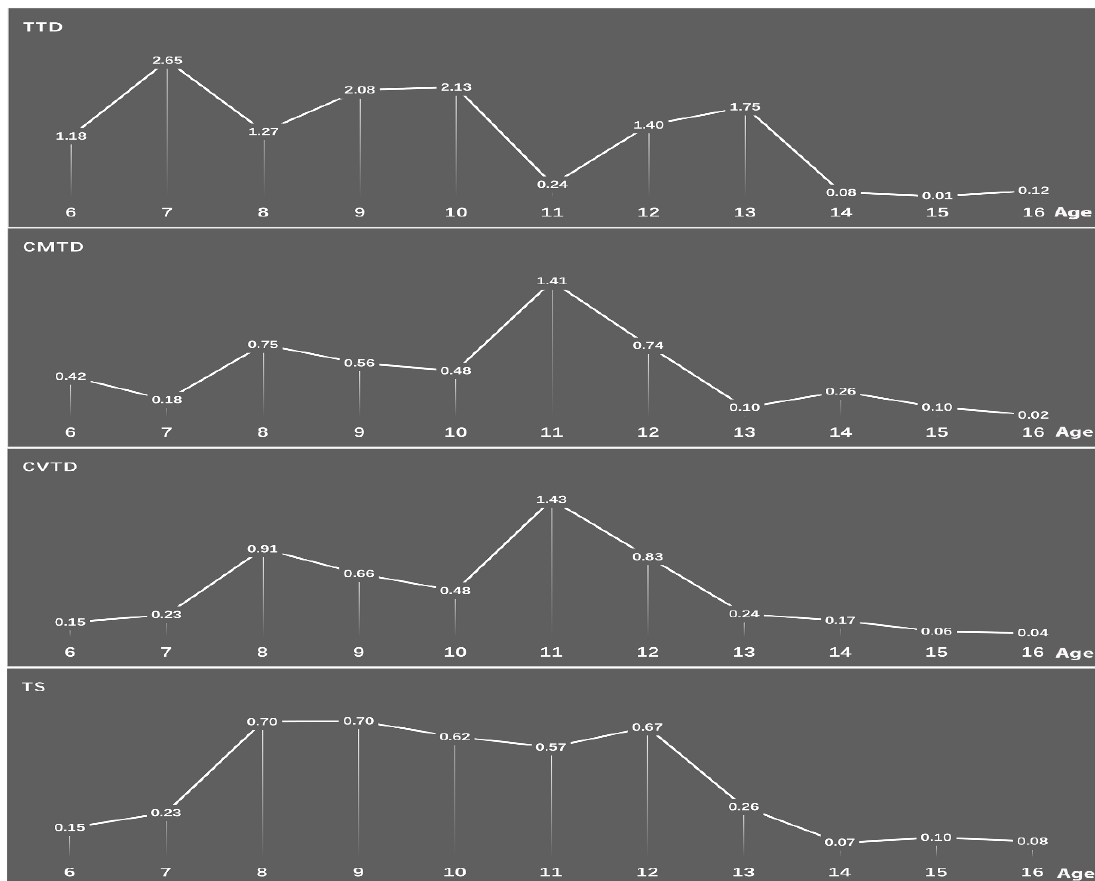
Figure 3. Changes in the prevalence of subtypes of T (TS: Tourette’s syndrome; CMTD: chronic mo- tor tic disorder; CVTD: chronic vocal tic disorder, TTD: transient tic disorder).